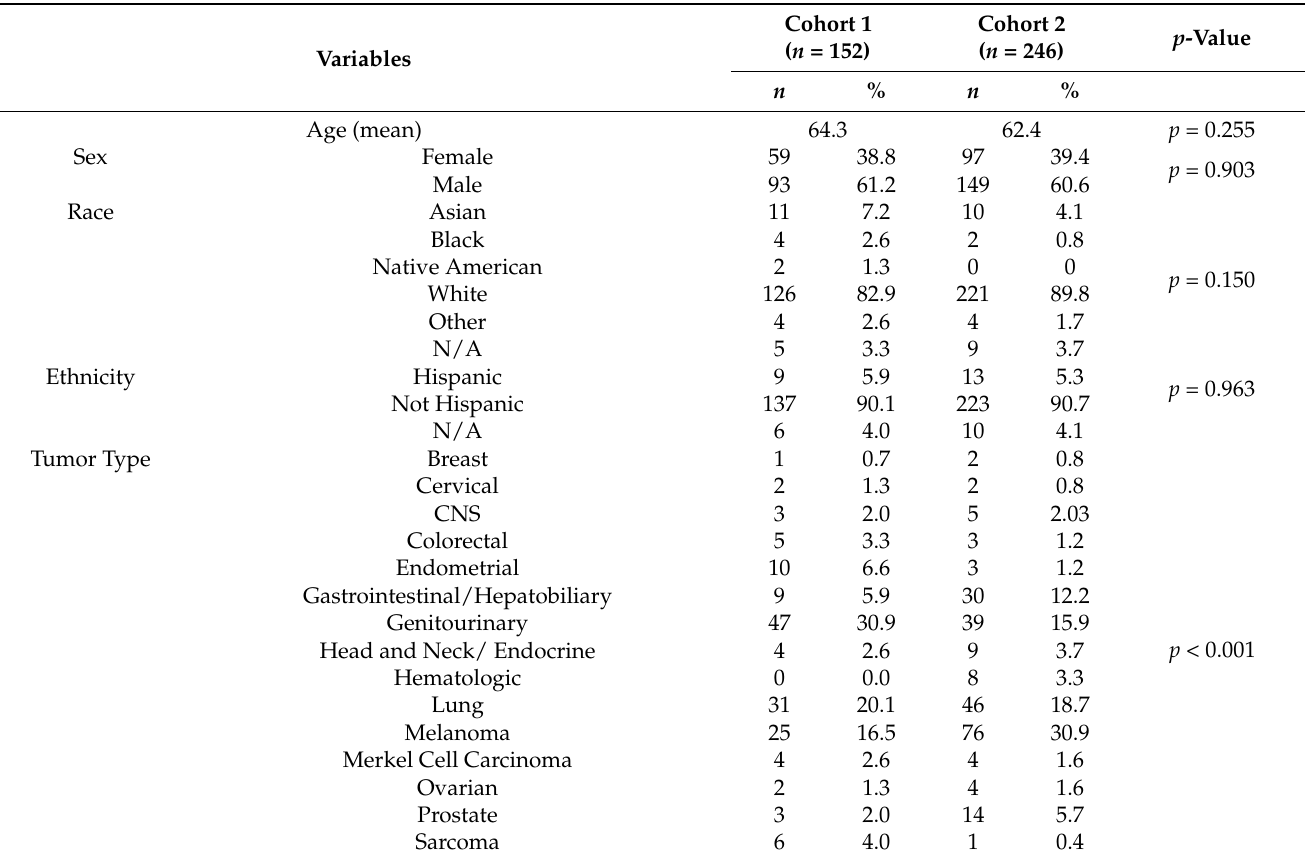
Table 1. Demographics of patients with